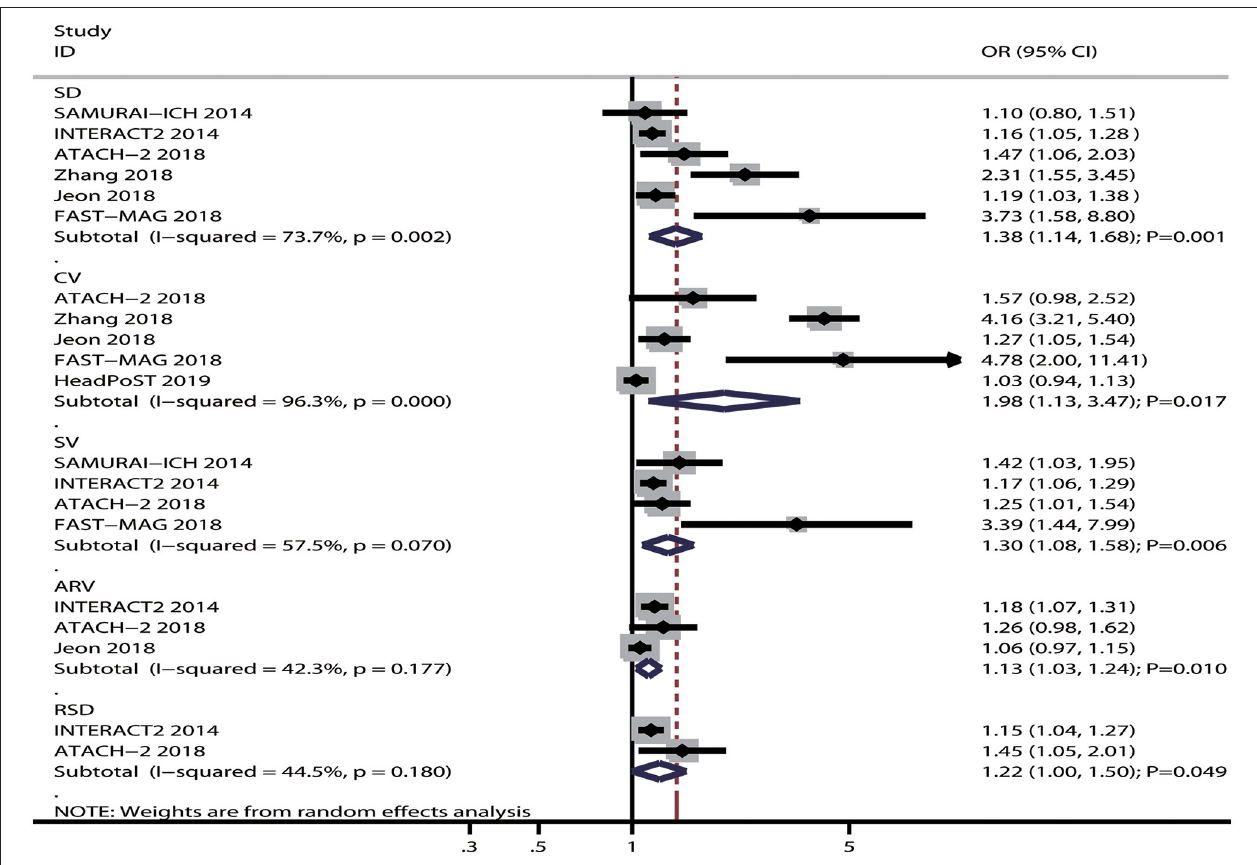
FIGURE 2 | Forest plot of the association between systolic BP variability and poor functional